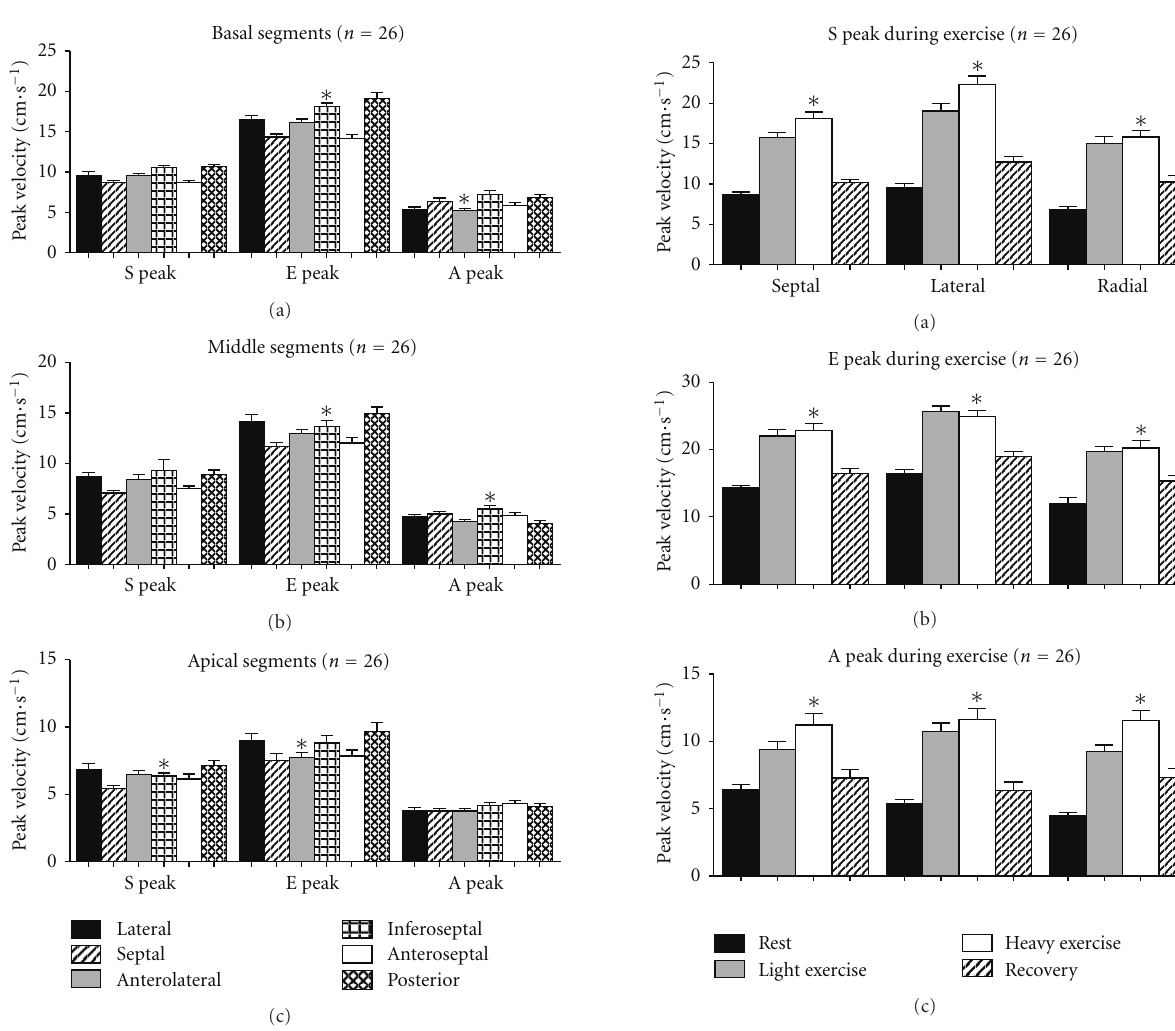
Figure 3: Resting tissue Doppler velocities for basal (a), middle (b), and apical (c) sections. S: systolic velocity; E: early diastolic velocity; A: late diastolic velocity; Error bars are standard error of the mean. ∗ P < . 001. P values are determined for the comparison of values from basal to apical segments using repeated measures ANOVA for within subject di ff erence with Greenhouse-Geisser correction.